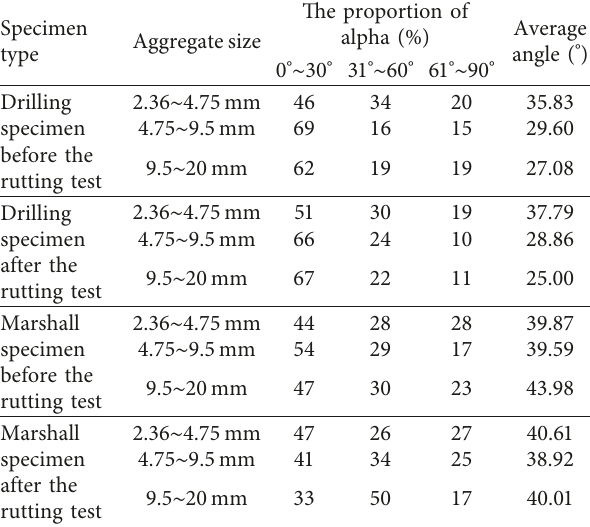
Table 4: Statistical table of